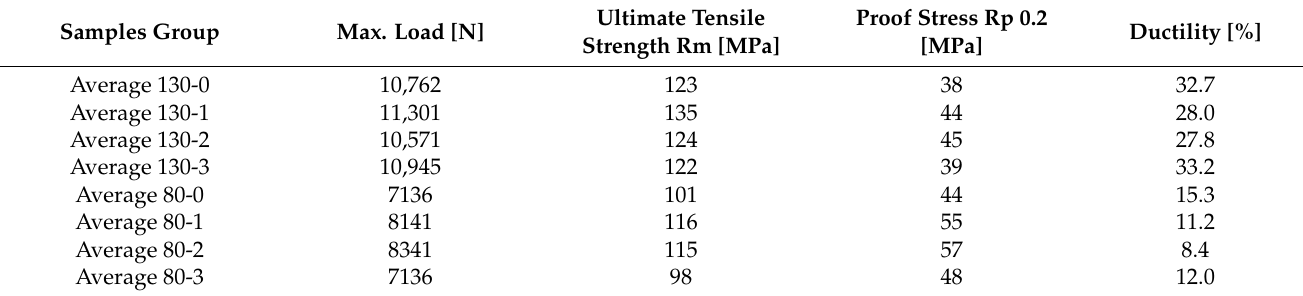
Table 5. Summary of the average values of mechanical parameters of samples type no. 0 to no. 3.